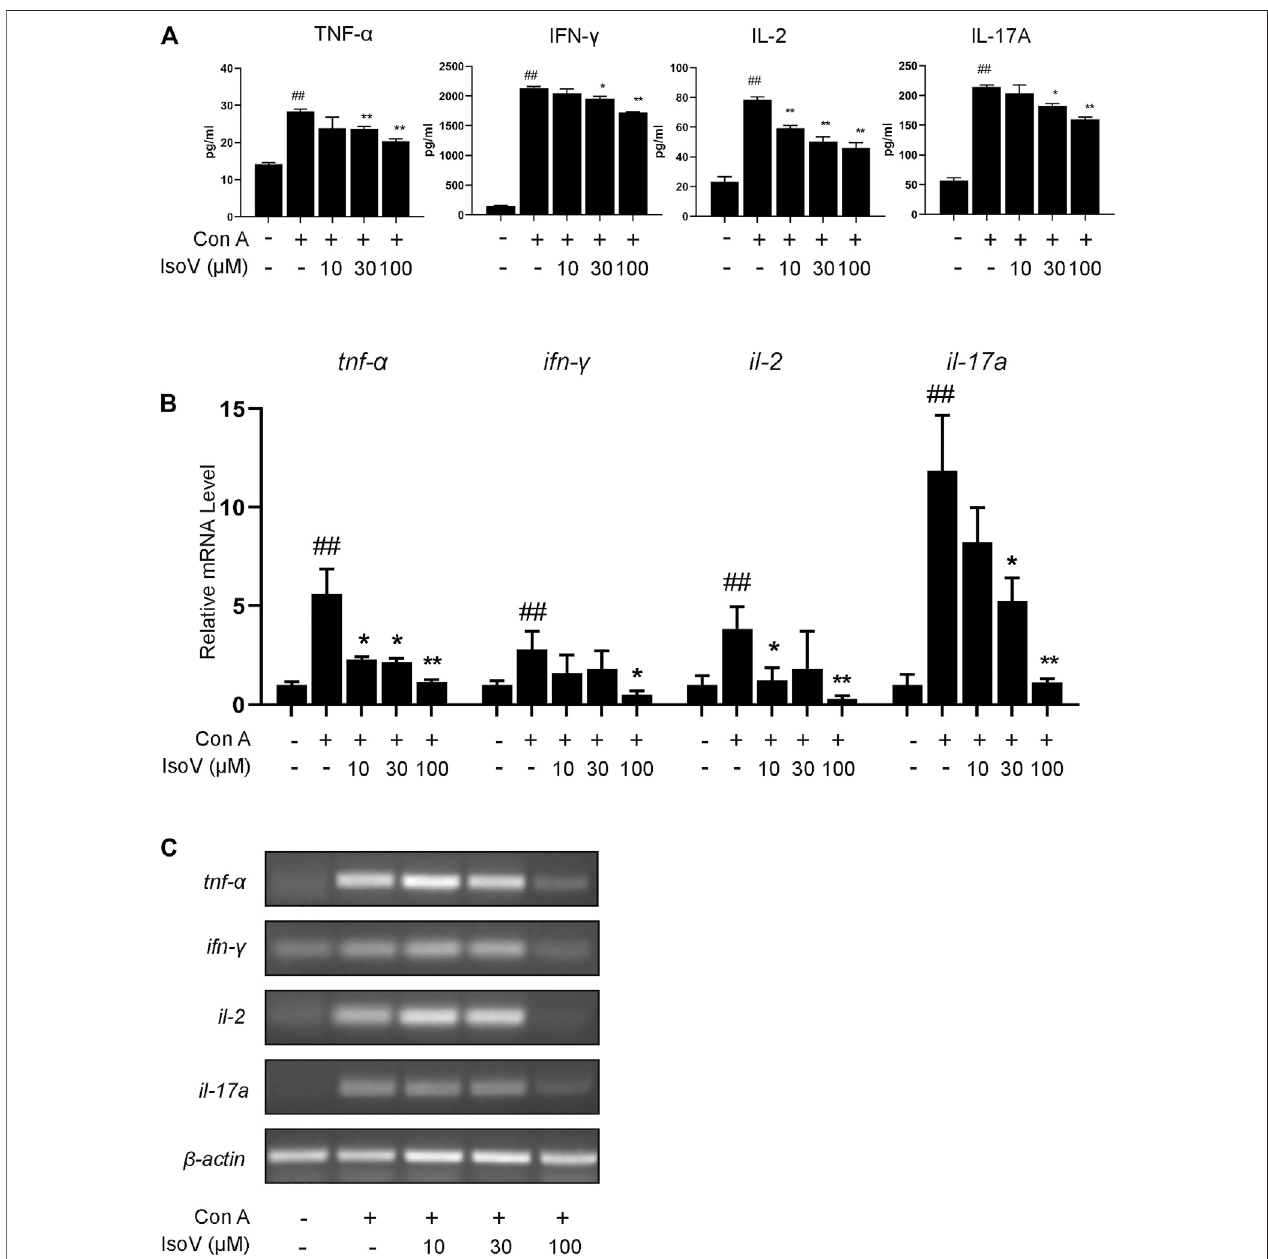
FIGURE 5 | Isovitexin inhibits T cells proin fl ammatory cytokines production in activated mouse T cells. Con A-activated T cells were treated with different concentrations ofisovitexin for 24 h; (A) Proin fl ammatorycytokines, in culture supernatantsofthe indicated groups, were determined byELISA; (B,C) Relative tnf- α ,ifn- γ , il-2, il-17a mRNA level was determined by Q-PCR (B) and RT-PCR (C) . Data are mean ± SEM and are representative of at least three independent experiments. Signi fi cant differences are expressed as ## p < 0.01 vs. Blank group, * p < 0.05, ** p < 0.01 vs. control (Con A-activated T cells).